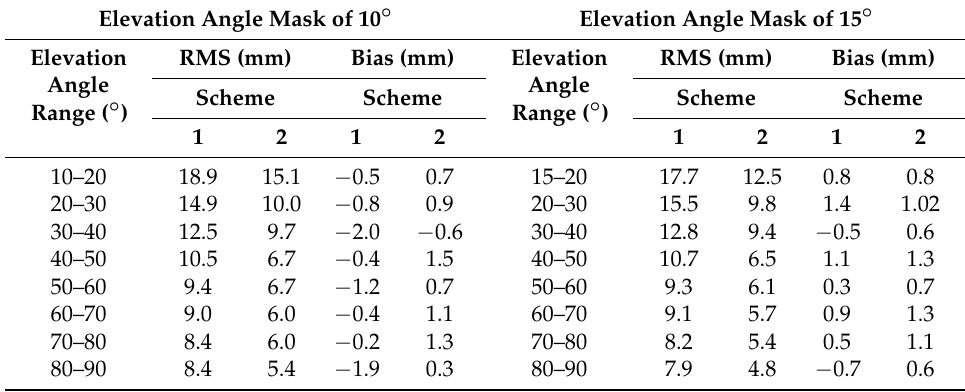
Figure 7. Scatter diagram of the slant wet delay residual of station BAIY using two schemes with 10° (top) and 15° (bottom) elevation angle masks over the experimental period of Doy 303 to 317, 2015. Table 3. RMS (Root Mean Square) error and Bias of the slant wet delay residuals derived from two schemes in various elevation angle range over the experimental period of Doy 303 to 317, 2015.